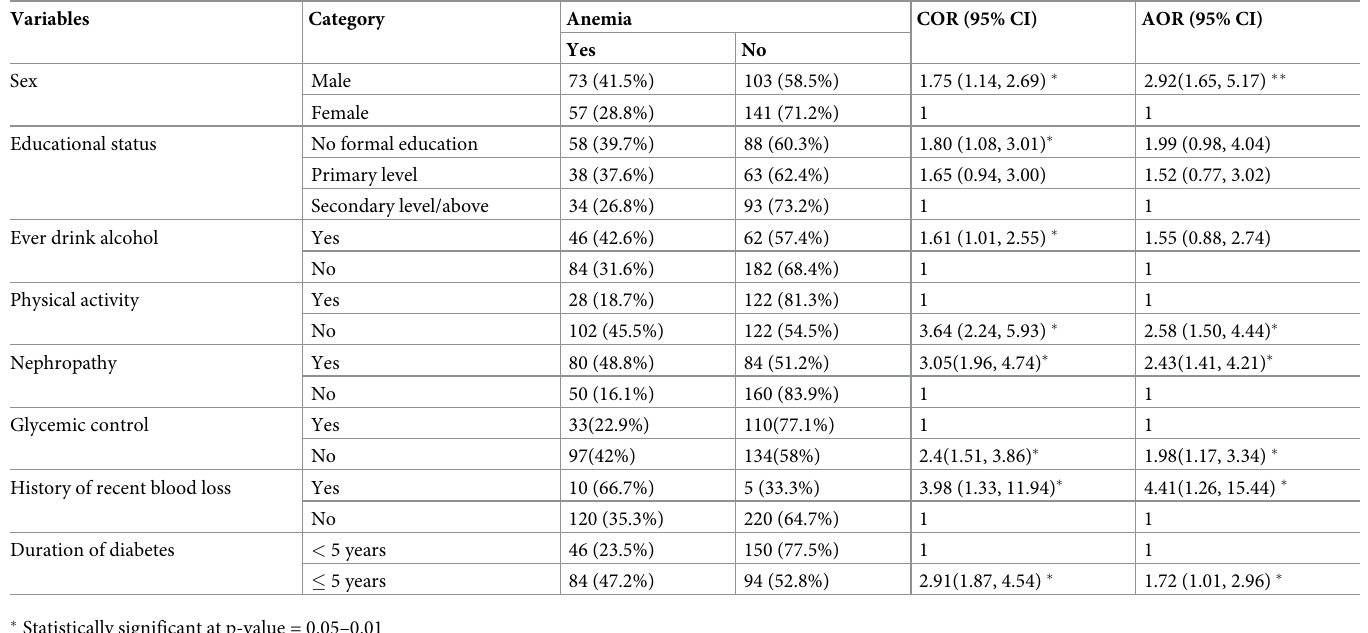
Table 4. Factors associated with anemia among T2DM patients attending public hospitals in Harari region, Eastern Ethiopia, February to March